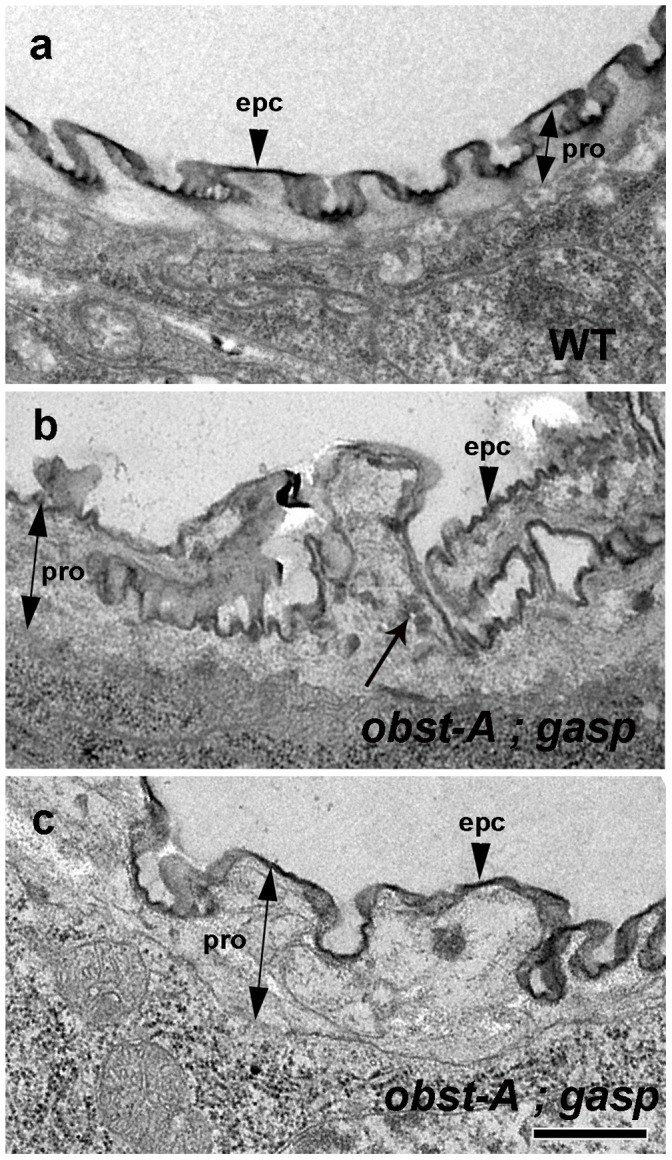
Ultrastructure of the tracheal lumen in obst-A; gasp mutants.(a–c) Transmission electron micrographs of wild-type and obst-A; gasp dorsal trunks at the end of embryogenesis. The wild-type embryos (a) show uniformly distributed chitin rich procuticle. In obst-A; gasp double mutant (b, c) the taenidial folds are irregular and the procuticle is distorted with granular amorphous accumulations (arrow). epc = epicuticle (arrow heads), pro = procuticle layer (double arrows). Scale bar: 0.5 µm.